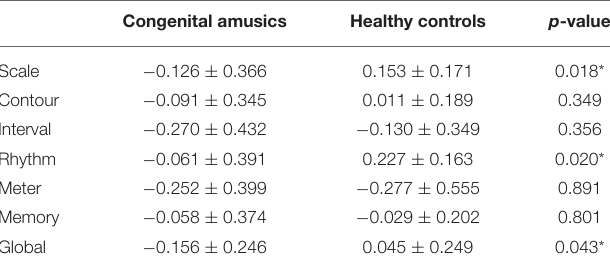
TABLE 5 | d’ value measured by SDT in the congenital amusia group and healthy control group. Congenital